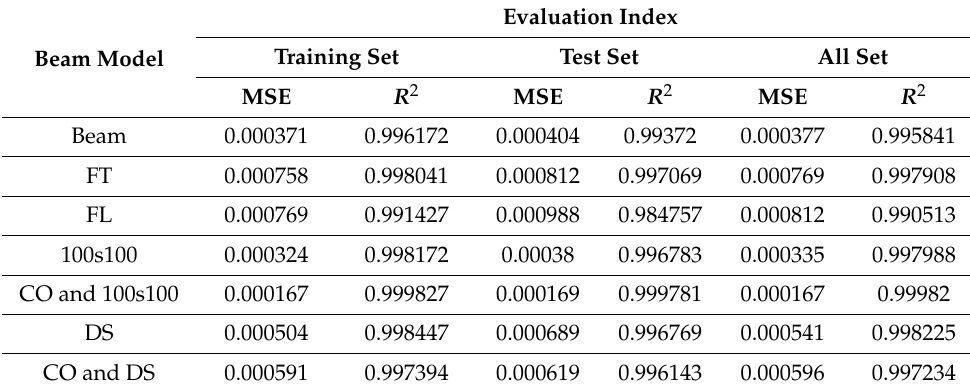
Table 7. Evaluation of statistical parameters of the ANN